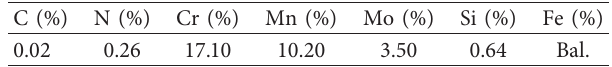
Table 1: Elemental composition of the raw stainless steel powder (wt.%).